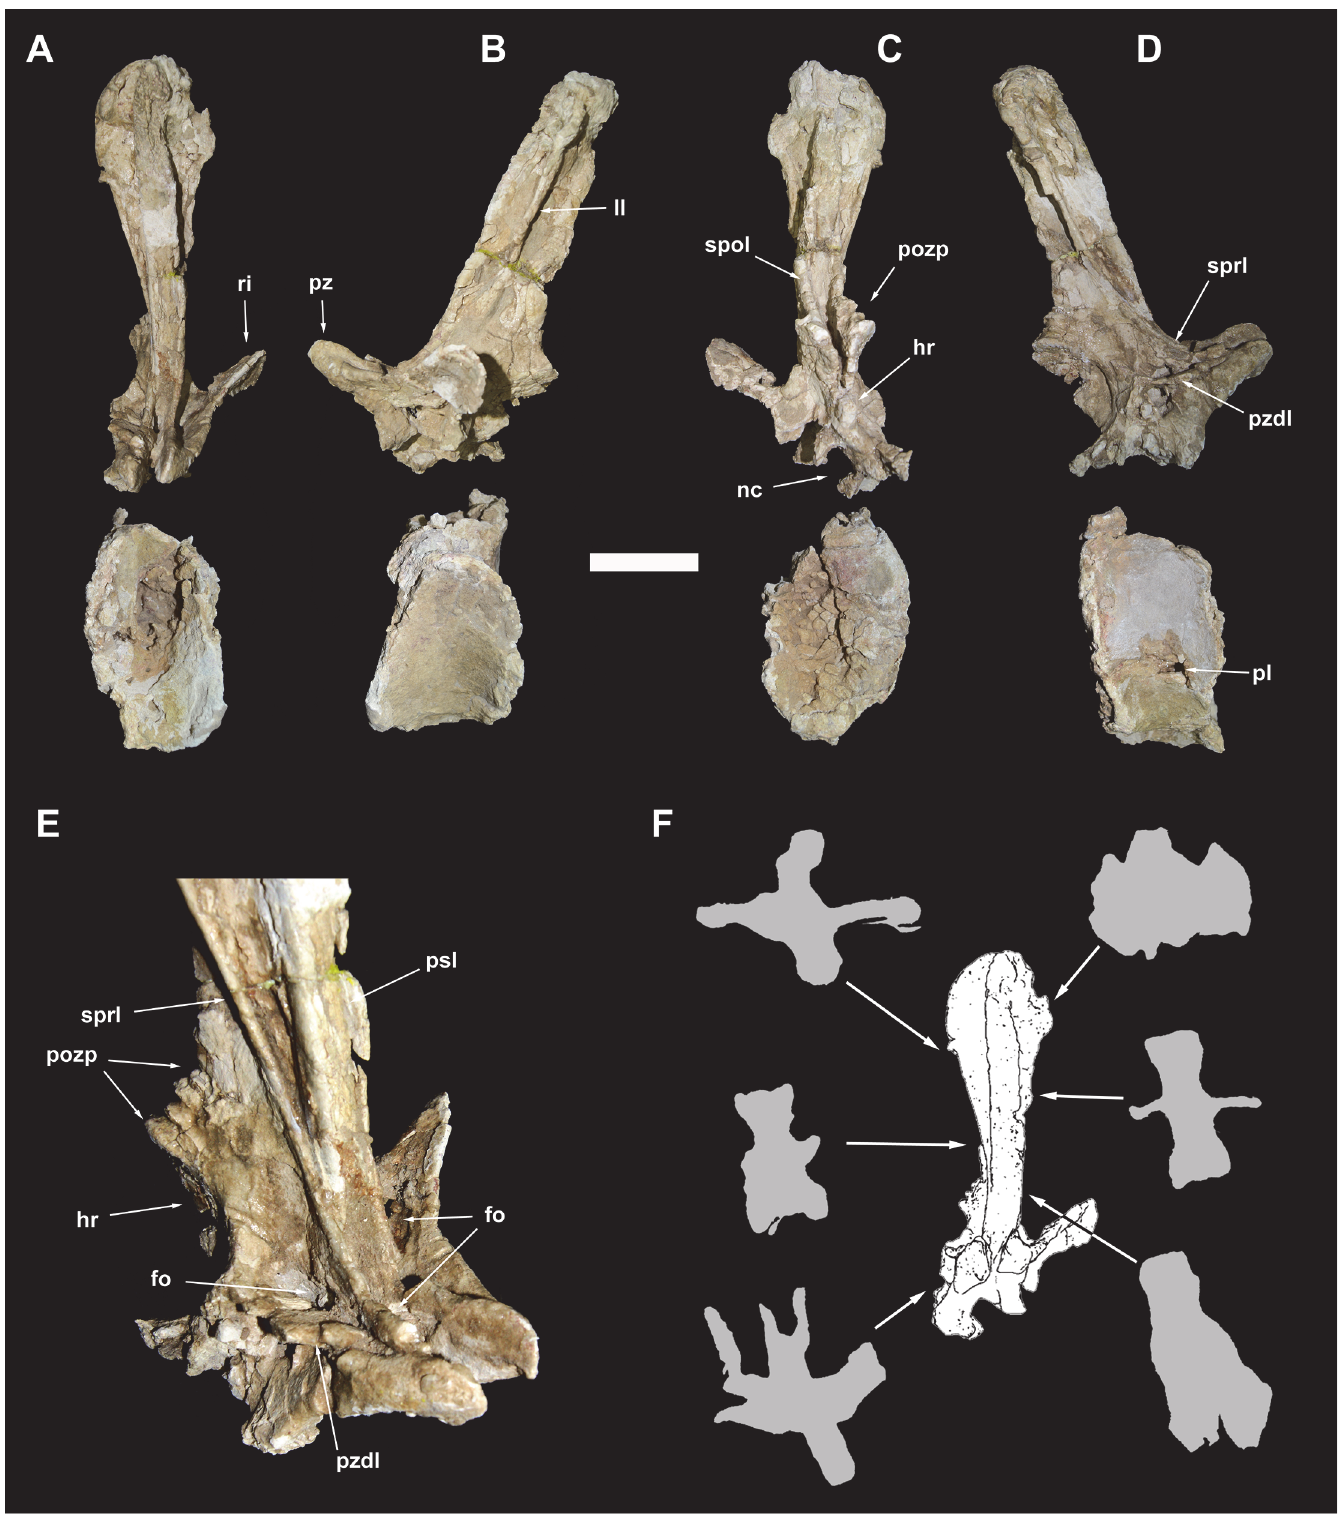
Fig 8. Caudal vertebra 5 of Tataouinea hannibalis . Vertebra in proximal (A), left lateral (B), distal (C), right lateral (D) views. Detail of neural arch in right proximodorsal view (D). Cross section shapes of neural arch (shown in proximal view) in six points indicated by arrows (proximal is bottom). Scale bar: